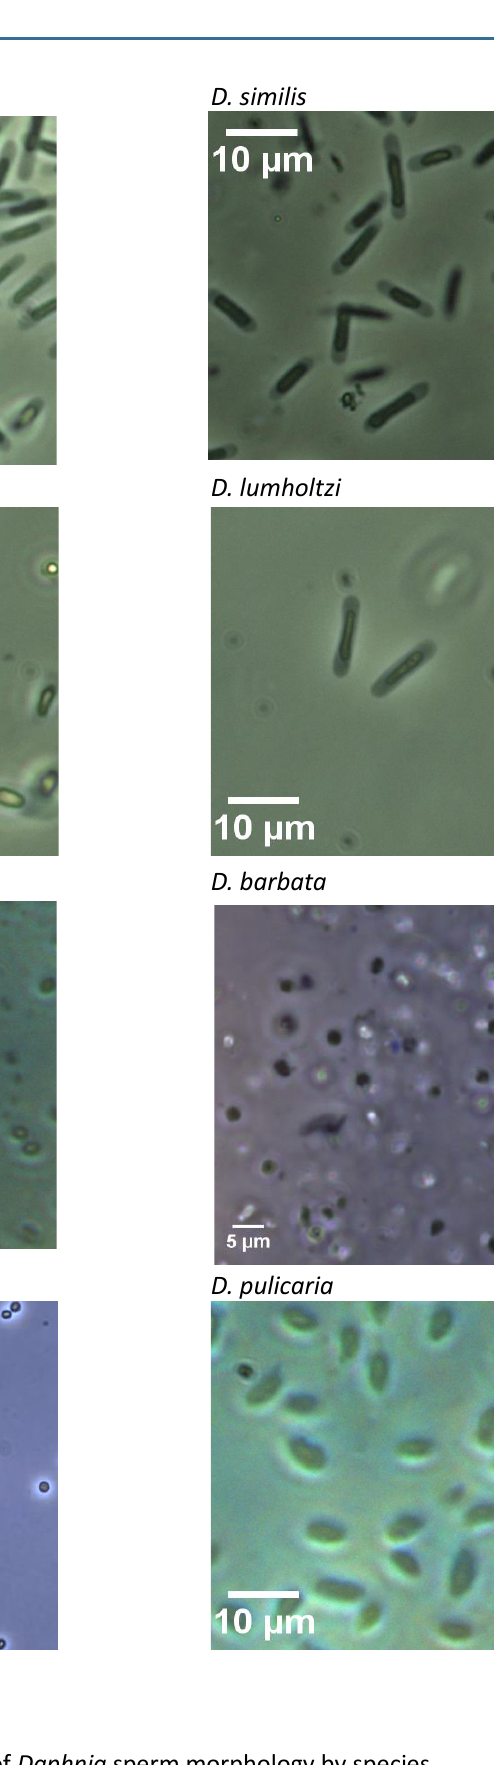
Supplementary figure 2: Illustration of Daphnia sperm morphology by